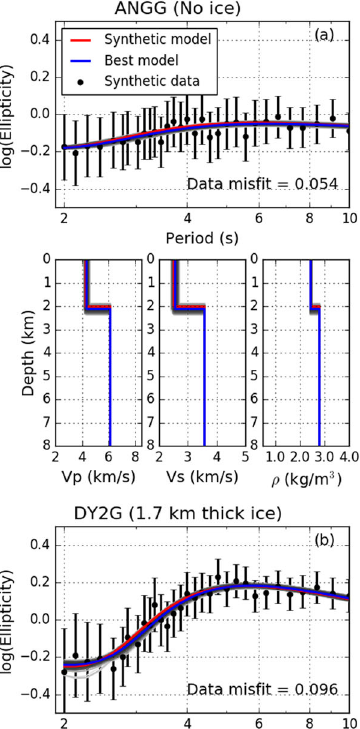
Fig. 9 Results from synthetic velocity model inversion tests for a 2 km subsurface layer. For each station ( a ANGG, b DY2G and c ICESG) the top panel compares the perturbed ellipticity data and fundamental model predictions for the true and the best- fi tting V s models. The bottom three panels are 1-D depth pro fi les of V p (left pane;), V s (middle panel) and density (right panel). In all panels the blue line is the model with the minimum mis fi t, the red line is the true model and the grey lines correspond to the solutions from the inversions with data mis fi t values within 20% of the formally best- fi tting model. The black dots and error bars in the top panel are the perturbed input